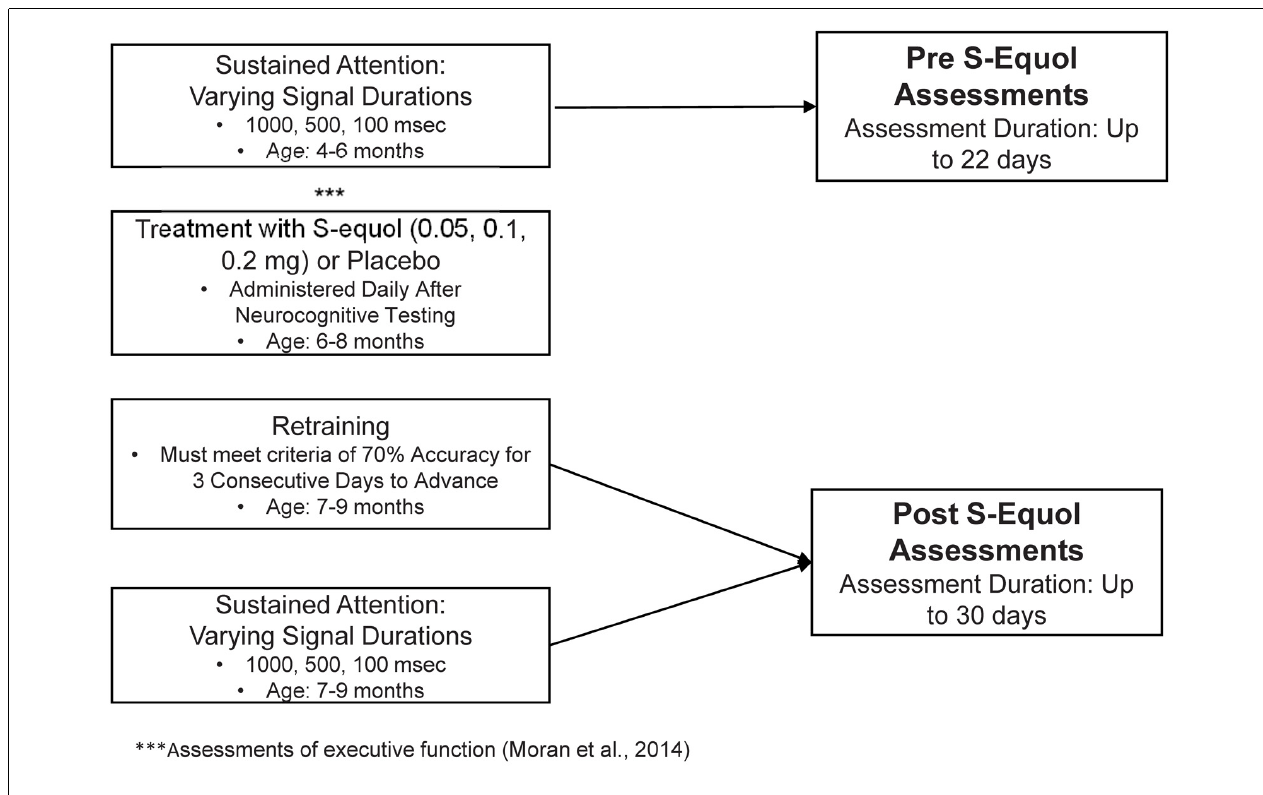
FIGURE 1 | Schematic of the experimental